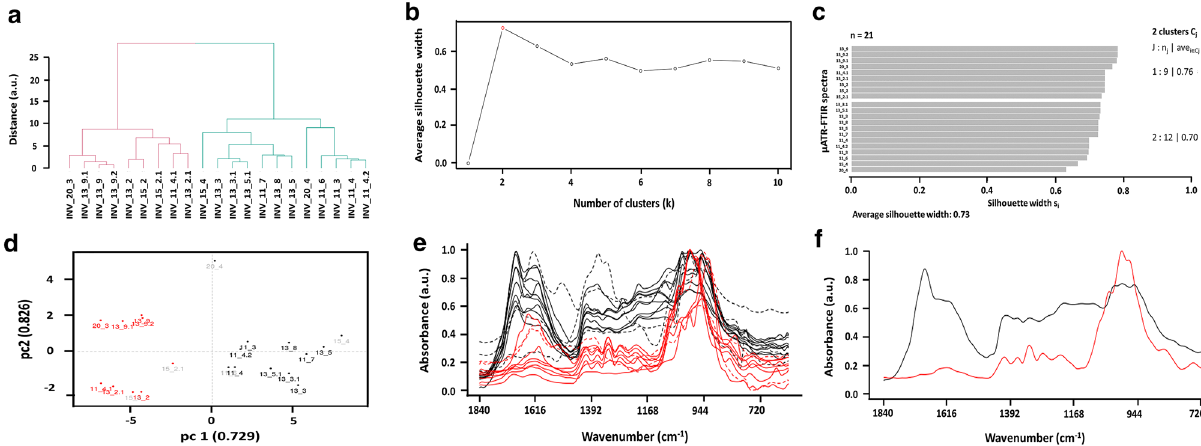
Figure 4. Statistical analysis performed on µATR-FTIR spectra for the 1840–719 cm −1 interval. The hierarchical relationship between the spectra is represented by the dendrogram depicted in ( a ), while ( b , c ) show the estimation of the number of clusters using the average silhouette width and the obtained silhouette of clusters, respectively. PCA results, µATR-FTIR spectra, and the most representative (i.e., deepest) curve for each identified cluster (highlighted with different colours) are illustrated in ( d – f ). For clarity, the most external spectra of the clusters are underlined in ( d ) with the grey colour.